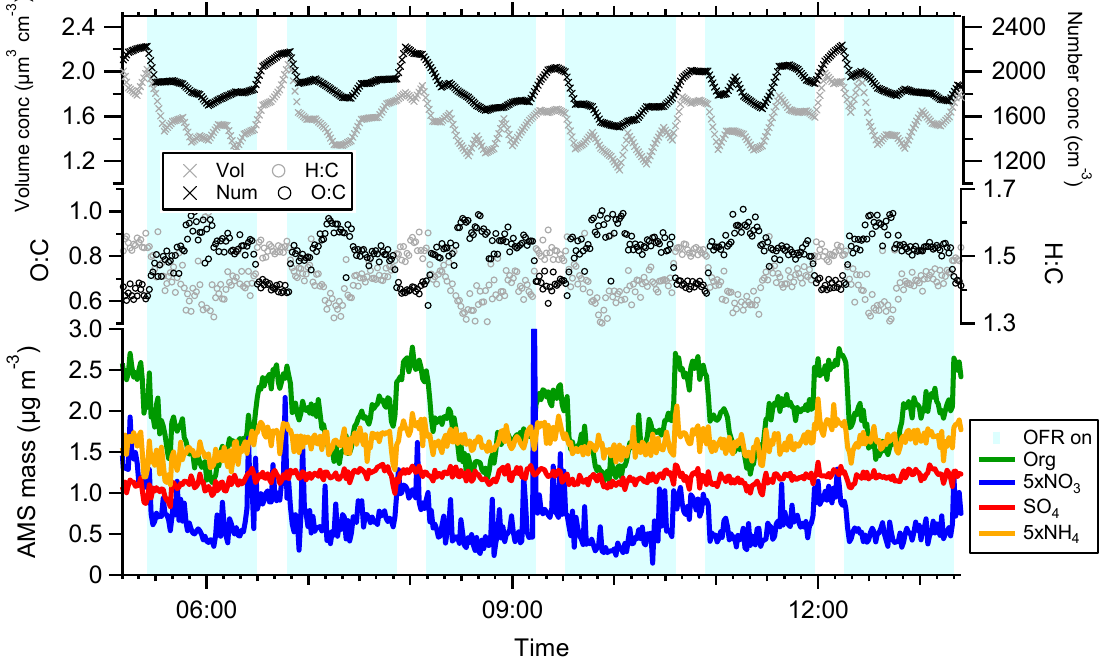
Figure 1. Typical time series from the campaign showing scanning mobility particle sizer (SMPS) volume and number concentrations, O:C and H:C elemental ratios and chemically resolved mass concentration (NO 3 and NH 4 are offset a factor 5 for clarity). Reactor measurements, highlighted in light blue gives lower volume and number concentrations, but higher O:C. Organics and nitrate is lost while sulphate is not affected.